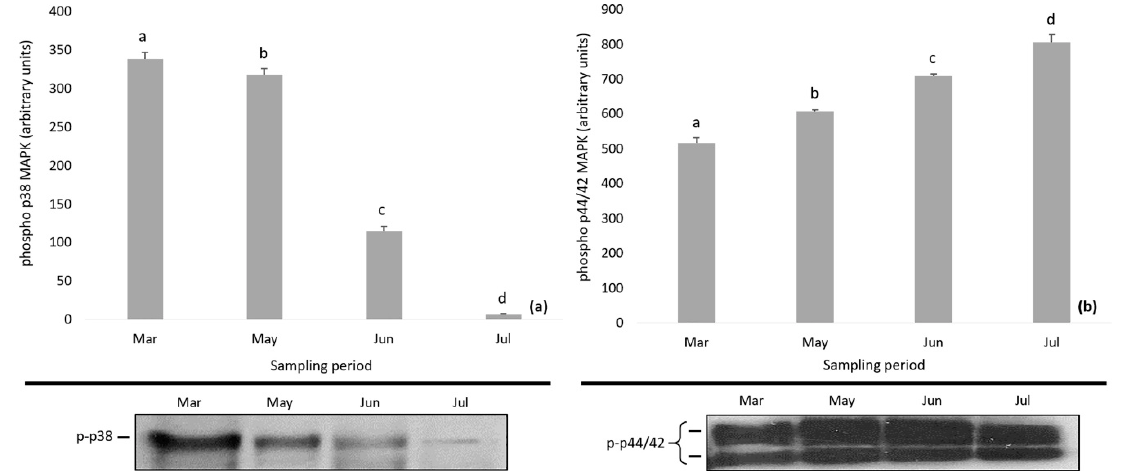
Figure 5. Phosphorylation of ( a ) p38 MAPK and ( b ) p44/42 MAPK in Daphnia magna during the study period. Values represent means ± SD; n = 3 technical replicates and different letter (a, b, c, d) denotes significant ( p < 0.05) difference between months.